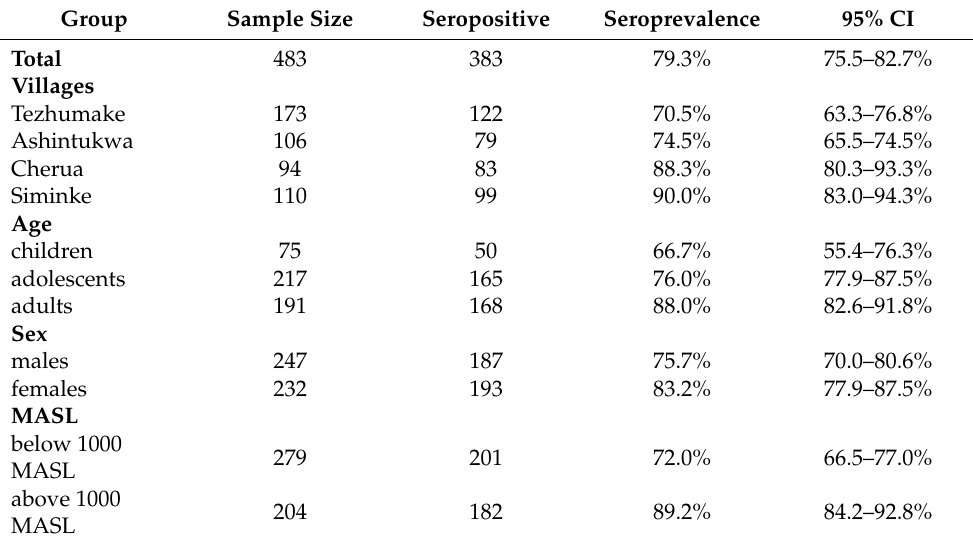
Table 1. Toxocara seroprevalences including 95% confidence intervals (CI) in the Wiwa community regarding different risk factors.